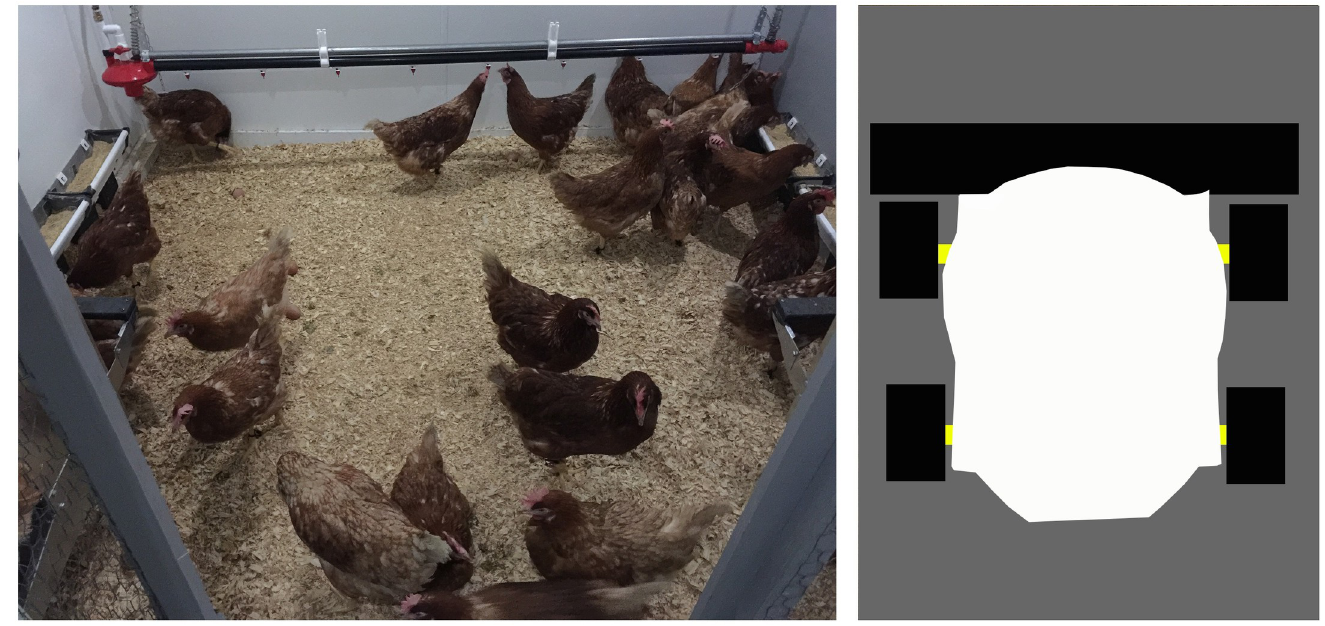
Fig 1. Illustration of the experimental settings. A photo of the experimental pen (left) and a schematic drawing of the robot (right).